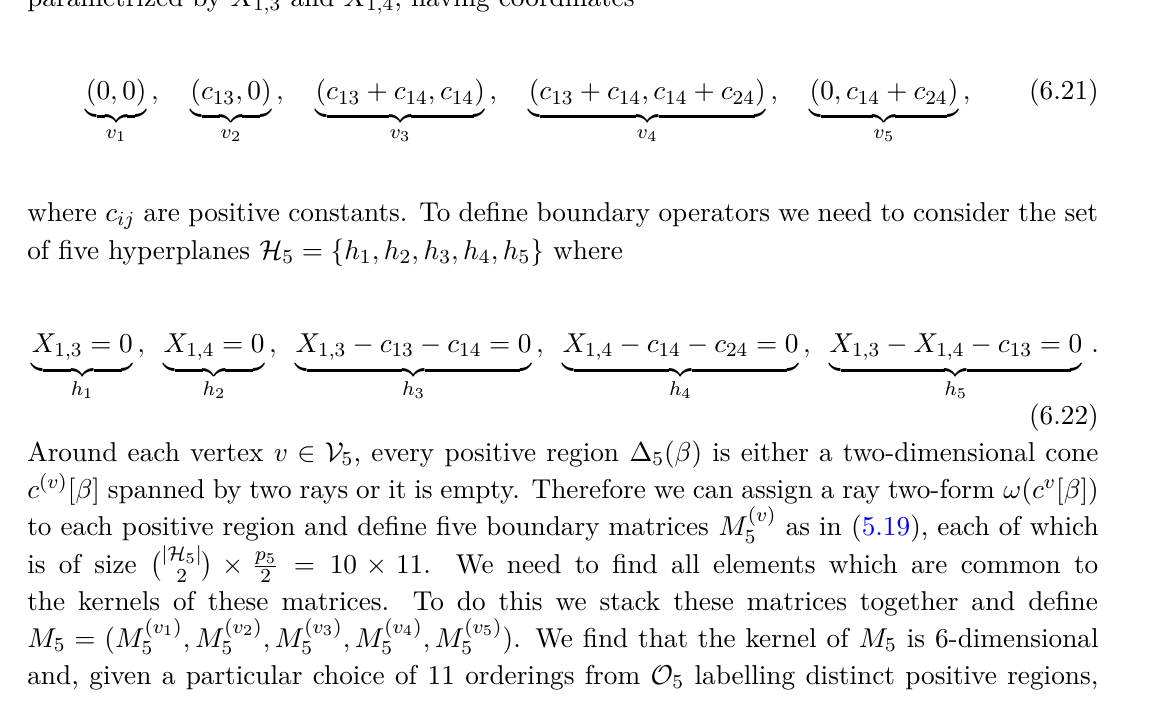
parametrized by X